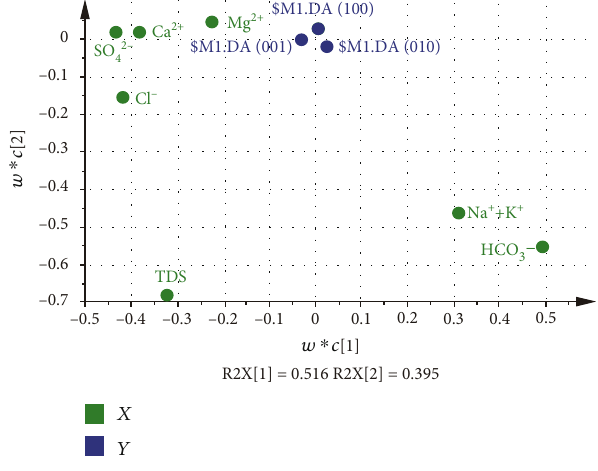
Figure 9: Loading scatter plot of the PLS-DA model.